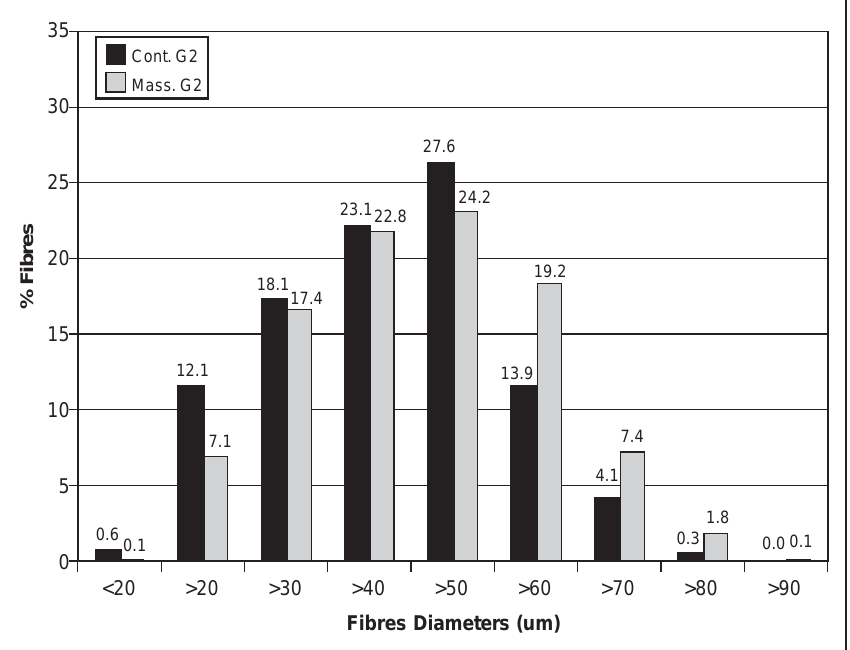
Figure 3: Frequency distribution of fibres from control (Cont. G2) and massaged muscle (Mass. G2) after three treatments of the whole lower